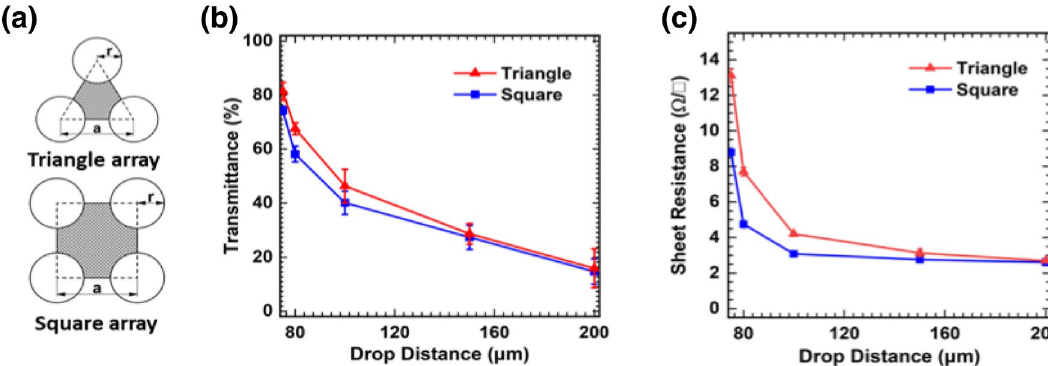
Figure 4. ( a ) Schematic illustration of the areal density of the aluminum area in the triangular and square array. ( b ) Transmittance at 550 nm of wavelength and ( c ) sheet resistance of the fabricated transparent electrode by drop distance with different drop pattern